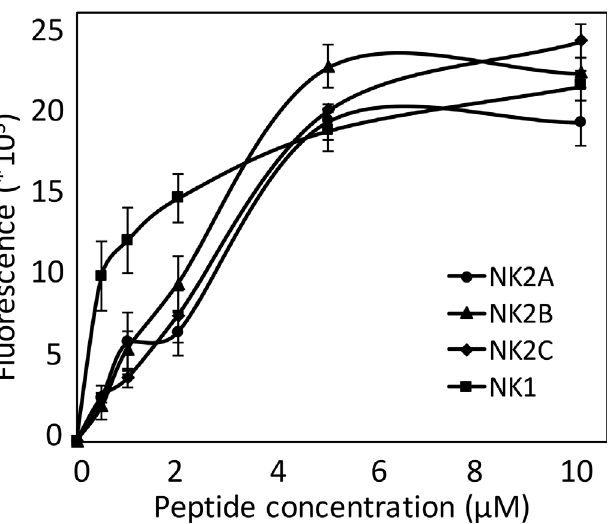
Fig 3. Intensities of released fluorescent dye from liposome plotted against concentration of bovine NK-lysin peptides.